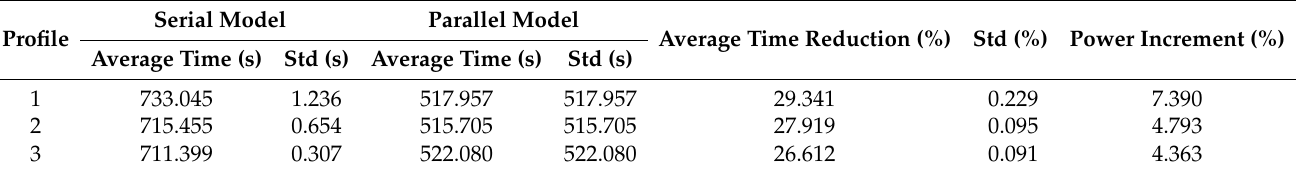
Table 3. Average reconfiguration times and standard deviations (std) to evaluate 105 configuration for an SP array with 15 rows ( N = 15) and 4 columns ( M =